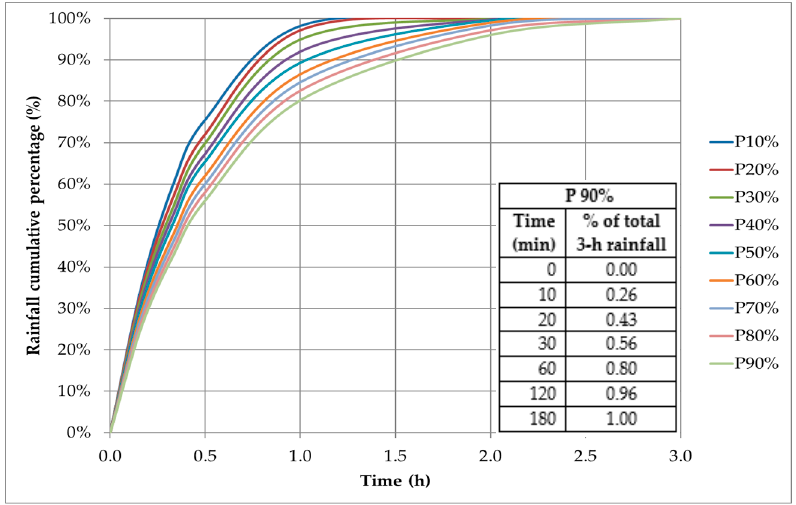
Figure 6. 3-h rainfall distribution pattern at Rafael Núñez airport weather station. Table 8. Peak flow values.